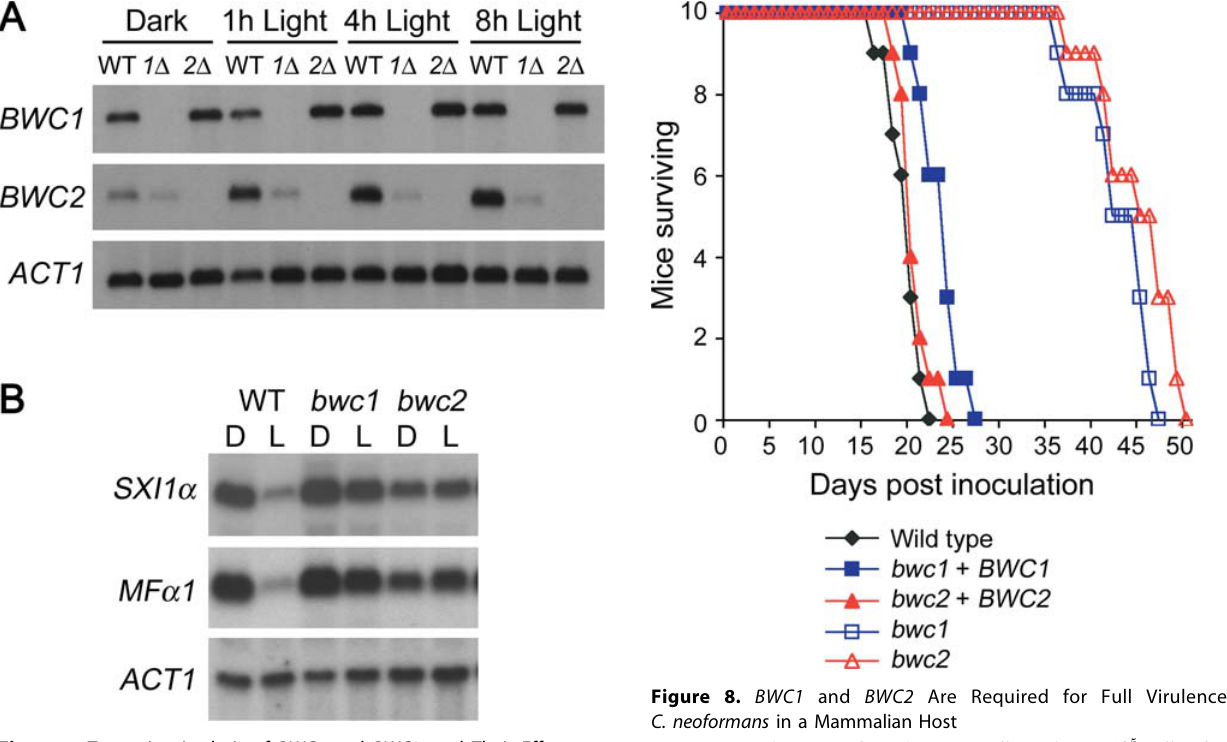
Figure 7. Transcript Analysis of BWC1 and BWC2, and Their Effects on Genes Required for Mating (A) Transcript levels of BWC2 are regulated by light, dependent on BWC1 . Wild-type, bwc1 (1 D ) or bwc2 (2 D ) strains were inoculated onto V8 agar medium and wrapped in foil. A set of plates was removed from darkness 1 h, 4 h, and 8 h before the end of a 24-h period.